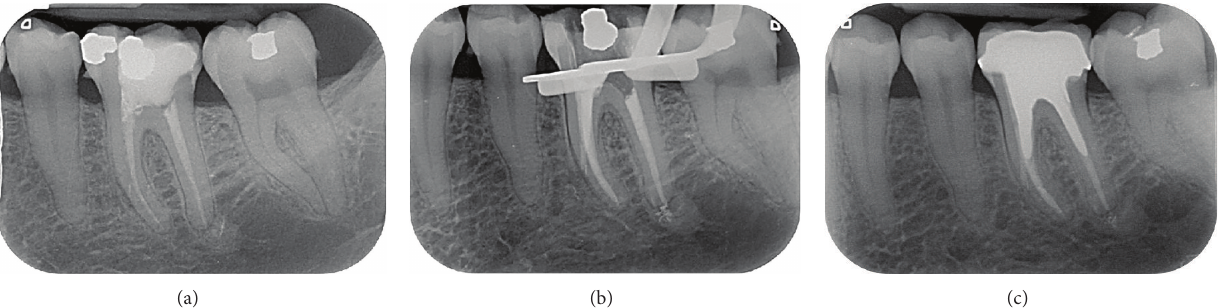
Figure 7: Successful endodontic retreatment of 36 symptomatic, with root perforation. (a) Preoperative X-ray: note the lateral periodontitis regarding the mesial perforation of the mesial root. (b) Peroperative X-ray: the perforation was filled with MTA and the root canal by vertical condensation of warm gutta-percha. (c) Follow-up for 1 year: tooth classified as “healed” (no symptoms, no